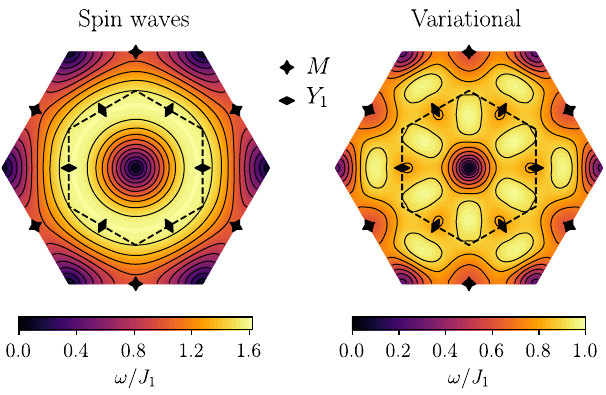
FIG. 5. Dispersion relation of the magnon branch (i.e., the lowest-energy excitation) as obtained within our variational approach (on the 30 × 30 cluster). The linear spin-wave results are also reported for comparison. Dashed lines represent the edges of the magnetic Brillouin zone. The presence of the roton minima at the M and Y 1 points in the variational spectrum is